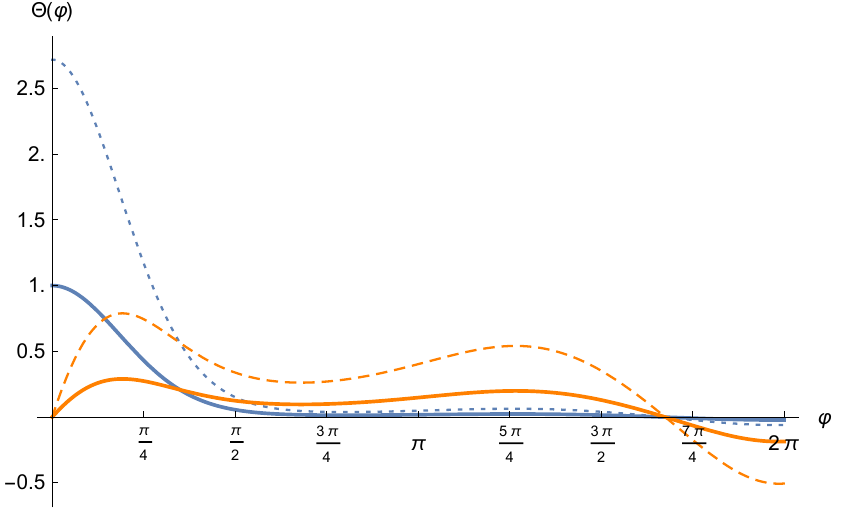
Figure 6. Second order Runge-Kutta approximations (obtained by the explicit midpoint method) to those pairs of particular solutions of la Cierva’s equation that were obtained in Sections 5 and 6, respectively. The blue dotted line depicts the first particular solution of that equation as it appears in Equation (61), whereas the orange dashed line illustrates the second particular solution of la Cierva’s equation (c.f. Equation (62)). On the other hand, the continuous curves correspond to the particular solutions of la Cierva’s equation as they were obtained in Section 5. As with Figure 5, ϕ varies in the range [ 0,2 π ] , which means a turn of the blade of the autogiro, and the choice of parameters has been as suggested by Mr. la Cierva, i.e., m = 0.5 and λ = 1. Notice that the y -axis has been labeled as Θ ( ϕ ) to denote an approximation to each particular solution of la Cierva’s equation for ϕ ∈ [ 0,2 π ]